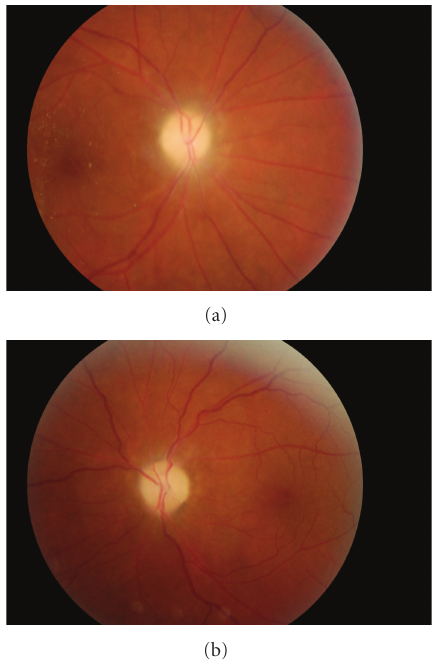
Figure 1: Bilateral ischemic optic neuropathy. The marked edema in the optic disc has a hemorragie near the papilla. Evanescence of optic